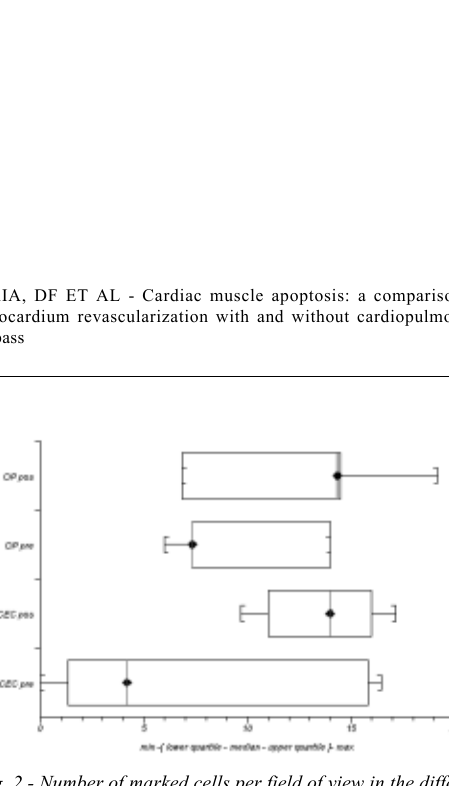
Fig. 2 - Number of marked cells per field of view in the different groups